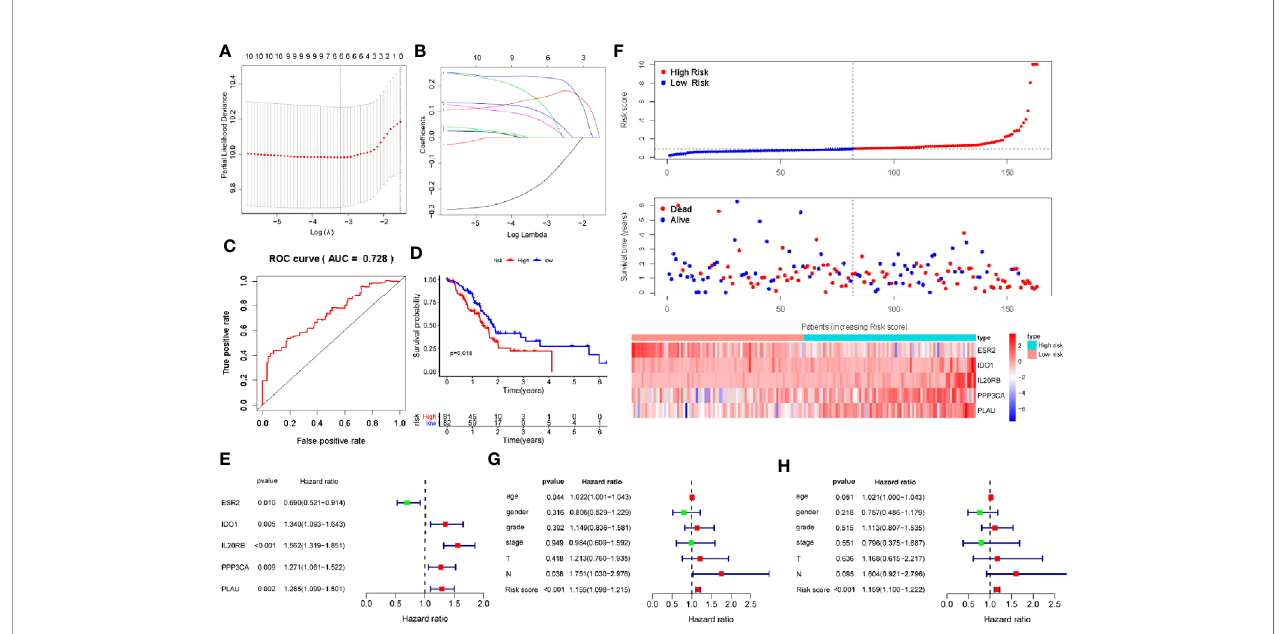
FIGURE 2 | Development of prognosis-associated immune signature (PAIS) for pancreatic ductal adenocarcinoma (PDAC) in the training cohort. (A, B) The least absolute shrinkage and selection operator (LASSO) Cox proportional hazards regression model identi fi ed 10 genes most related to overall survival (OS). (C) ROC curve analysis of the PAIS for OS. (D) Kaplan-Meier survival curves of OS for patients with PDAC. (E) Prognostic values of fi ve selected genes using multivariate Cox proportional hazards regression analysis. (F) Heatmap of fi ve-gene expression pro fi les, PAIS distributions, and live status of each patient in the high- and low-risk sets. (G, H) Univariate (G) and multivariate (H) regression analyses of the associations between PAIS and clinical variables for the predictive value of